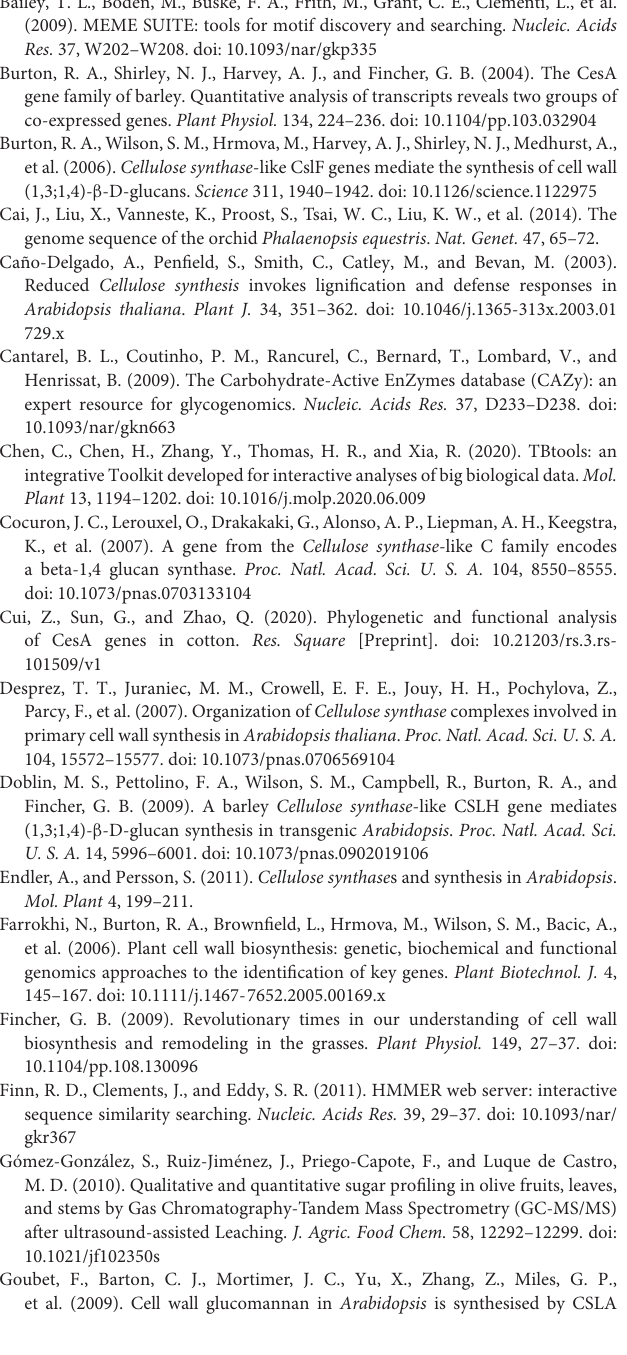
Supplementary Figure S7 | Multiple alignment of the deduced amino acid sequences of Cellulose synthase in A. shenzhenica . Conserved cysteine residues are marked by red frames. Supplementary Figure S8 | Sequence structures of the alternative splicing transcripts of the D. officinale genes. UTRs and exons are indicated using blue and yellow rectangles, respectively. The solid lines indicate introns. The scale bar (bp) indicates the length of the corresponding